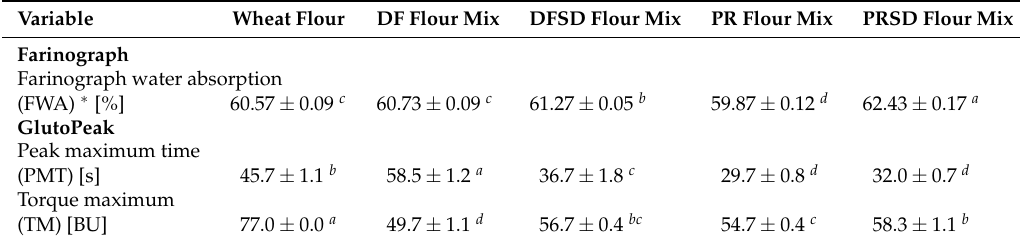
Table 5. Flour properties of wheat flour (used for control) and faba bean flour mixes (used for faba bean